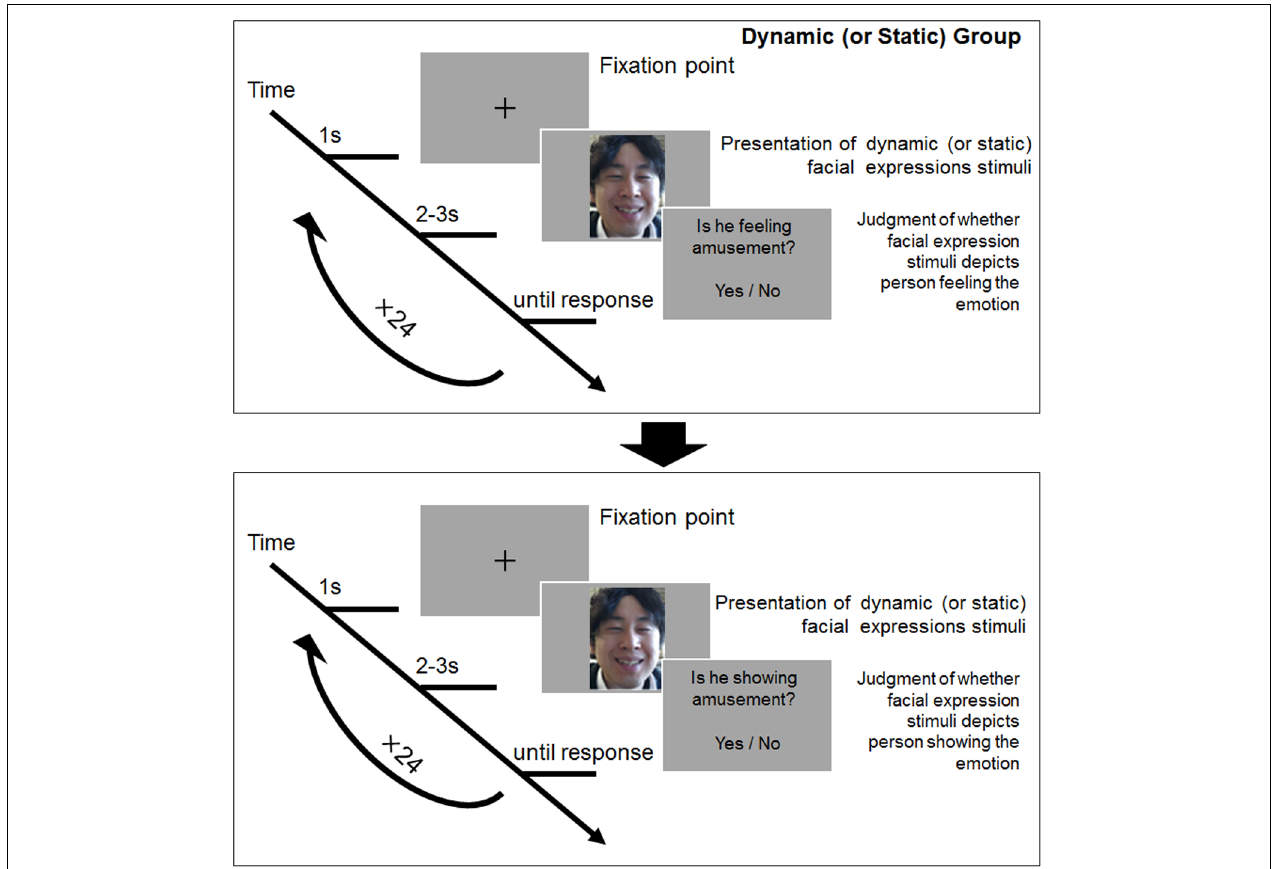
FIGURE 1 | A depiction of the experimental flow for each